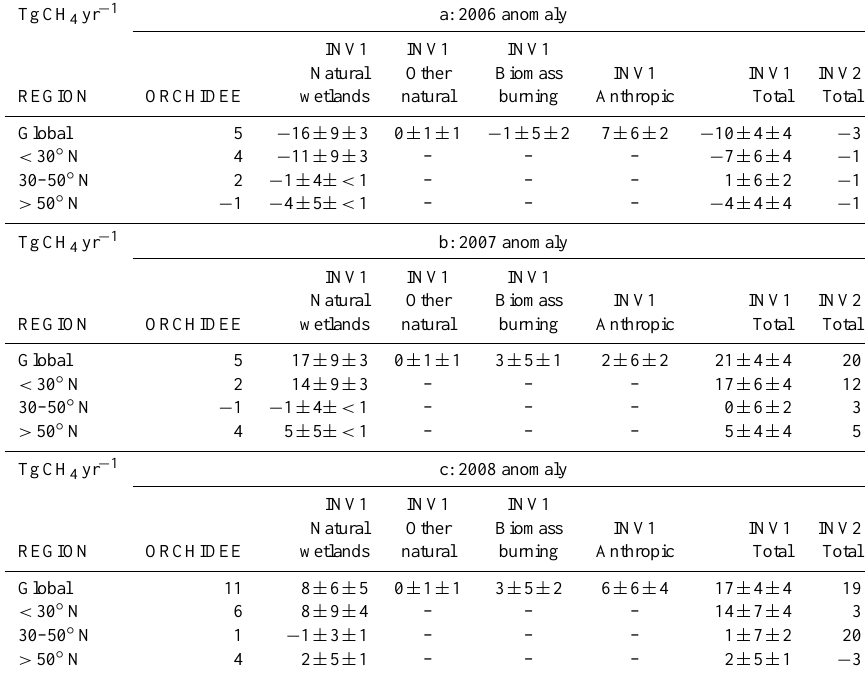
Table 3. Methane surface flux anomalies for 2006 (a), 2007 (b), and for 2008 (c), relative to the 1999–2006 period (see Table 2), in TgCH 4 yr − 1 . From left to right, CH 4 fluxes are given: for natural wetlands from ORCHIDEE model, for four categories of emissions inferred by INV1 (wetlands, other natural, biomass burning, total), and for the total emissions inferred by INV2. From top to bottom: global, < 30 ◦ N, 30–50 ◦ N, > 50 ◦ N. Total fluxes are the sum of surface emissions and soil uptake. The first uncertainty assigned to INV1 is the residual uncertainty returned by the inversion procedure (1-sigma). The second uncertainty is the spread of the 11 inversions of INV1 (1-sigma). For INV1, regional anomalies are not shown for sources other than wetlands as generally very